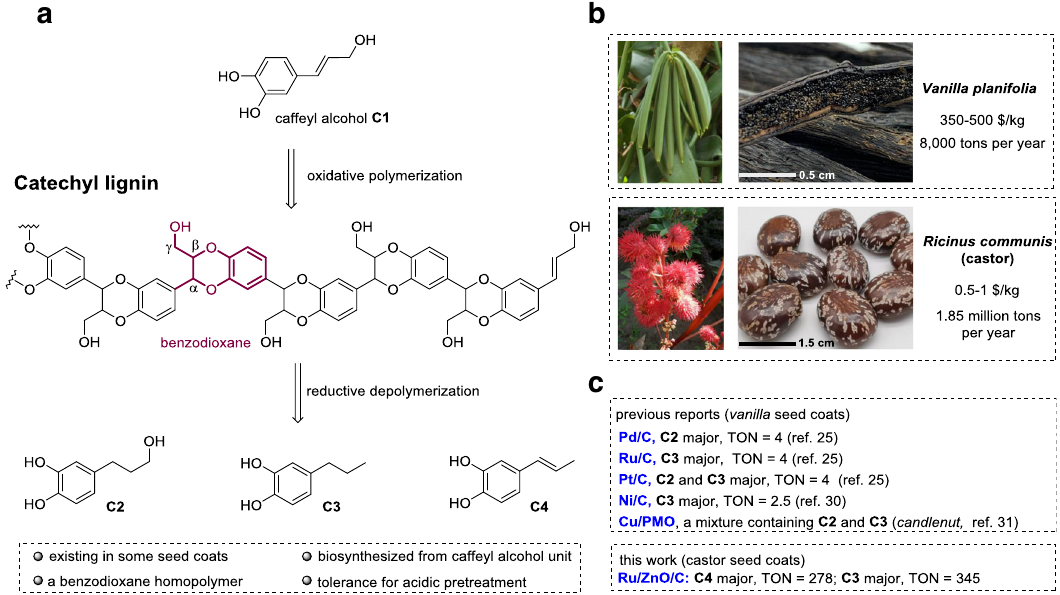
Fig. 1 Catechyl lignin (C-lignin) structure and characteristics. a Overview of C-lignin structure. b Comparison of price and annual output between Vanilla planifolia and Ricinus communis (castor). c Previous reports on C-lignin